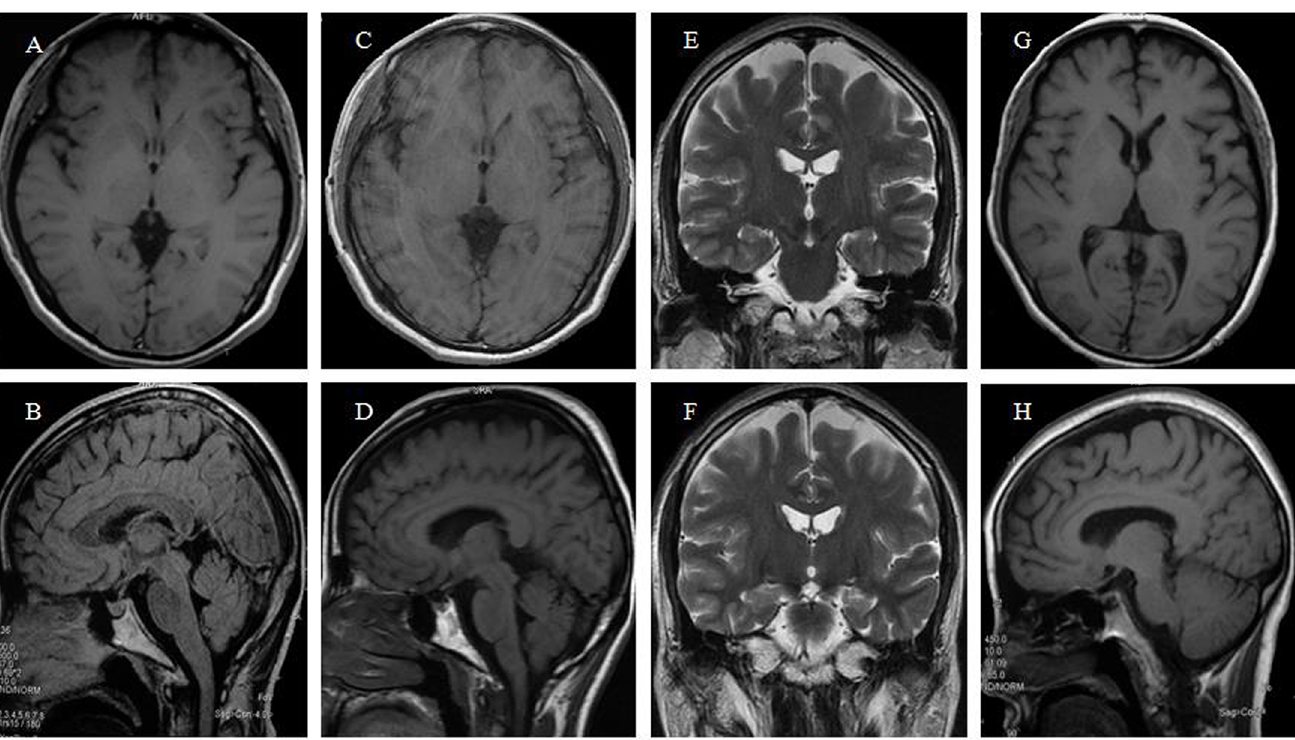
Fig 2. Brain MRI and CT scans of two patients of the family. A,B: brain MRI scan of the proband at the age of 42; C-F: brain MRI scan of the proband at the age of 44; G,H: brain MRI scan of the patient Ⅳ 20 at the age of 46. Atrophy of whole brain was present in both patients. The frontotemporal atrophy was the most noticeable, while in the proband the hippocampus was relatively